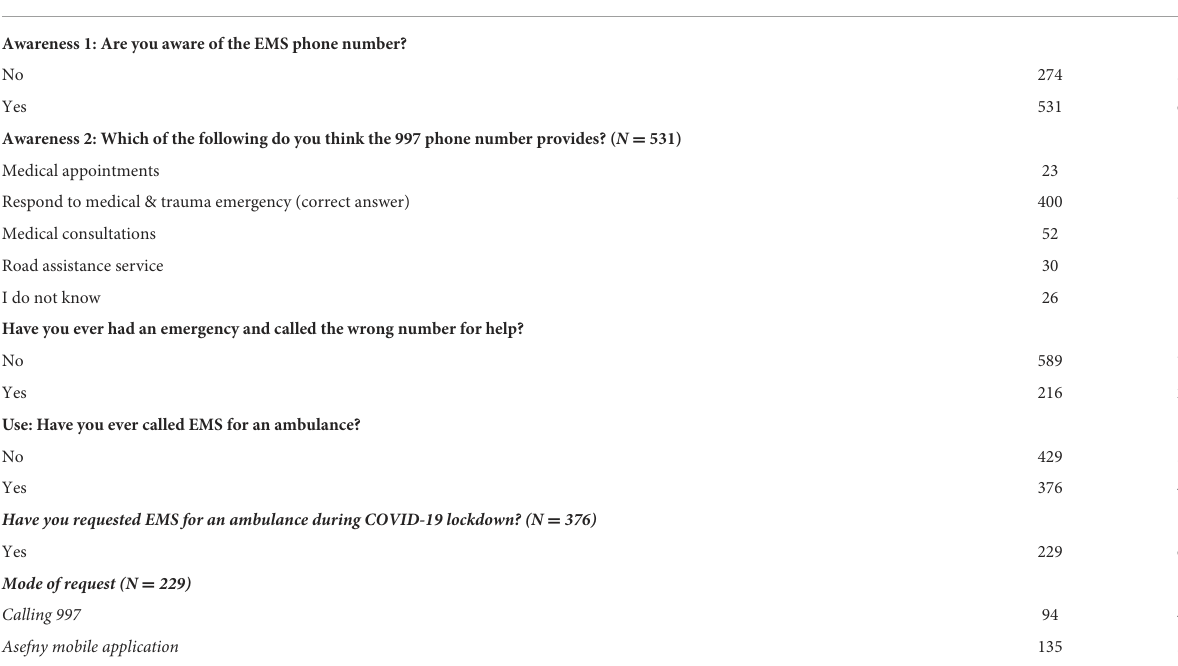
TABLE 2 Public awareness and use of EMS phone number ( N =